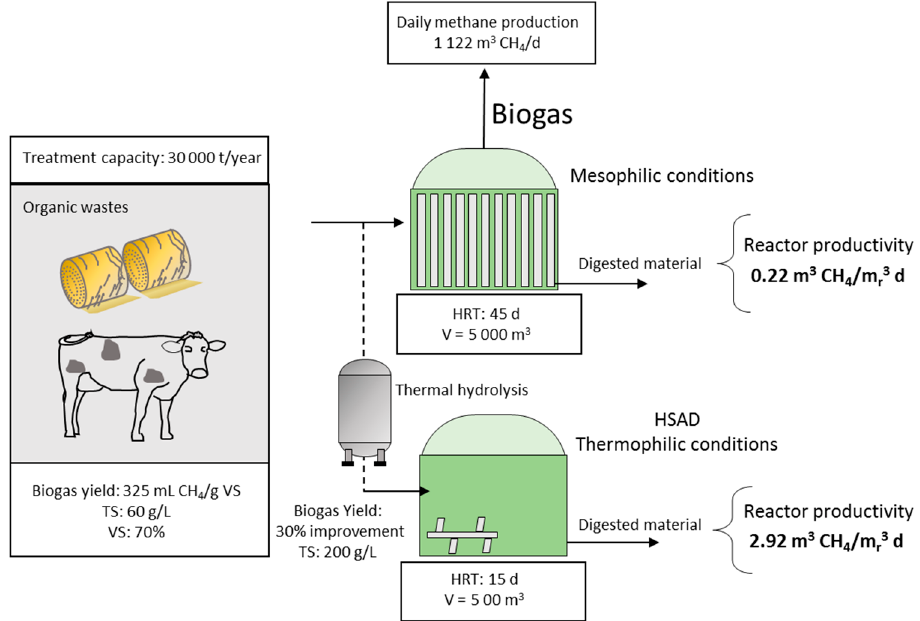
Figure 3. The schematization of reactor productivity increase expected when operating under high solid anaerobic digestion (HSAD) and considering an improvement in biogas yield thanks to the application of pre-treatments. Negative effects associated with accumulation of VFA and NH 3 were disregarded. TS: total solid, VS: percentage of volatile solids, HRT: hydraulic retention time, V: volume of the reactor, mr 3 represents the unit used to measure reactor volume expressed in cubic meters.